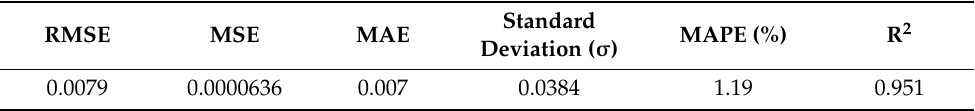
Table 6. Statistical errors RMSE, MSE, MAE, std, MAPE and R 2 for Simscape Li-ion model validation versus ADVISOR